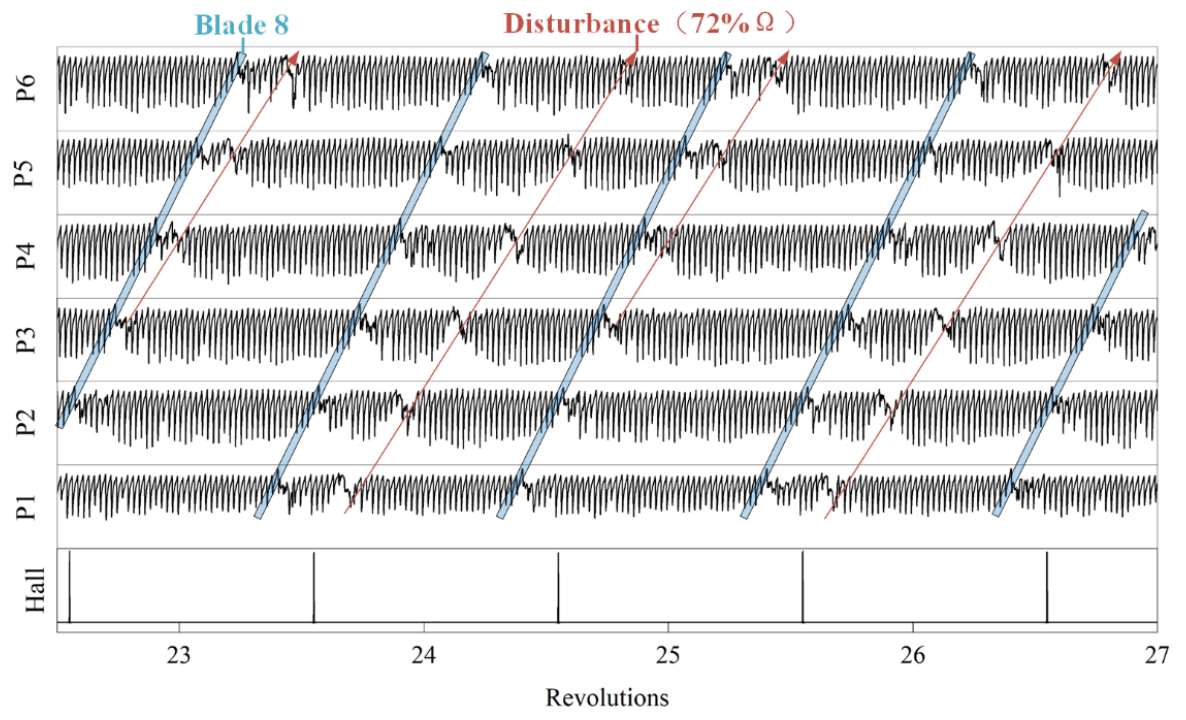
Figure 13. Casing static pressure trajectory of Case 1 at the near-stall point.